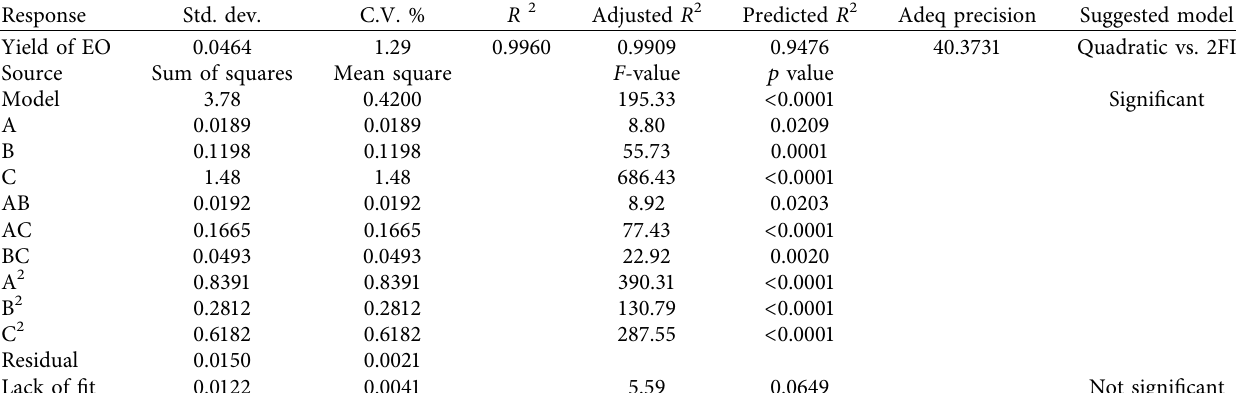
Table 3: Response surface model adequacy and analysis of variance (ANOVA) for a yield of EO.